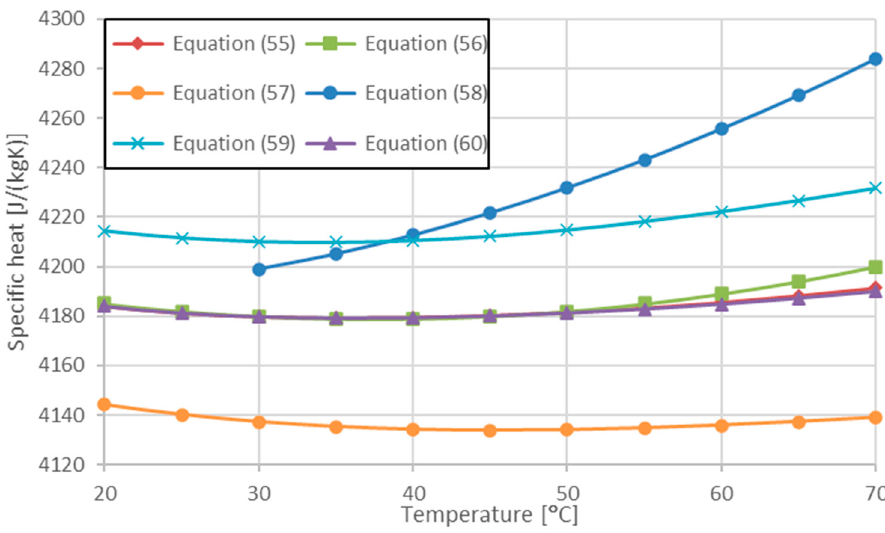
Figure 9. Specific heat of water.